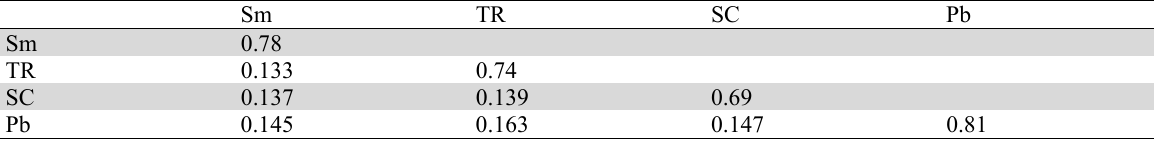
AVE and square of correlations between constructs.